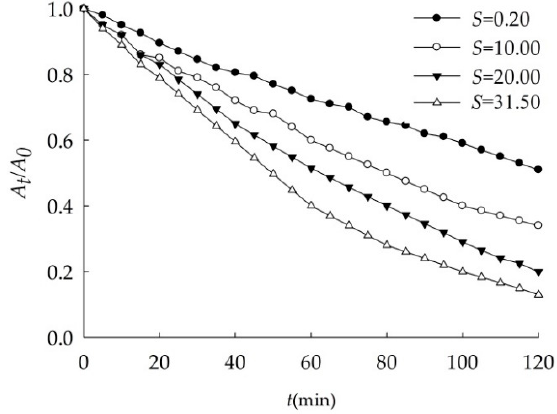
Figure 5. Effects of salinity on the sedimentation of nano-Al 2 O 3 (pH = 8.00).